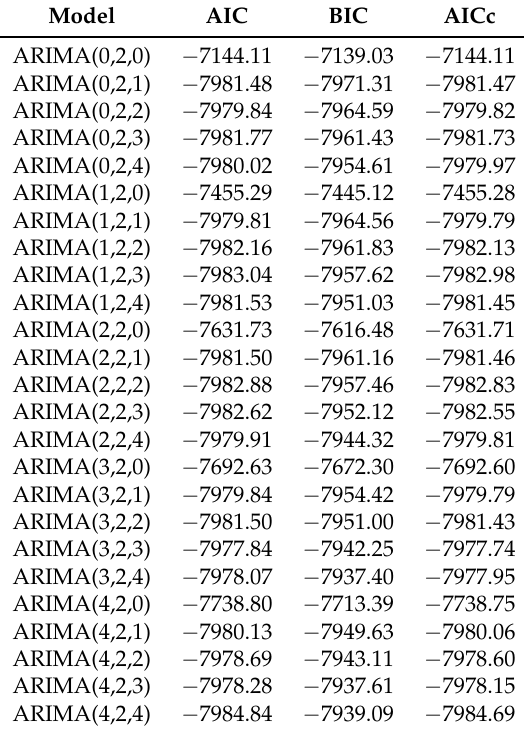
Table 1. ARIMA (p,d,q) model comparison.